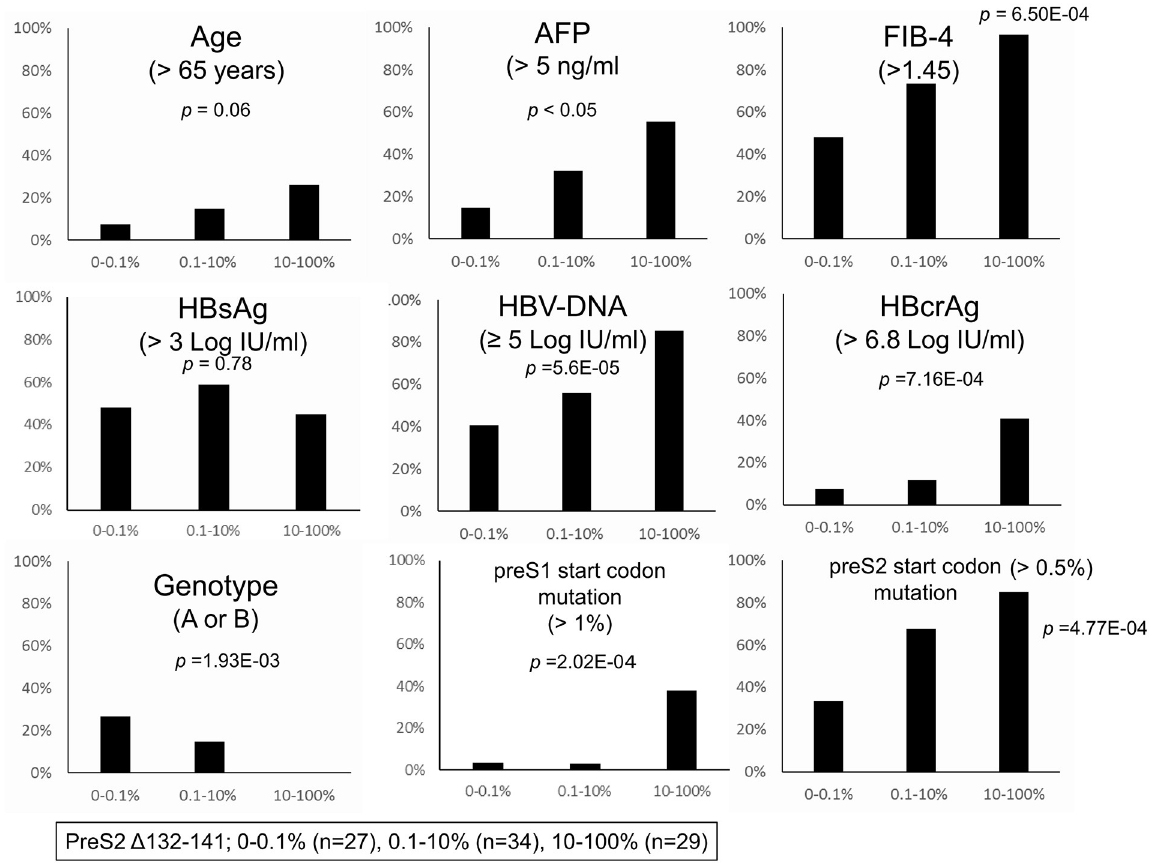
Fig 4. The correlations between the frequency of preS codon 132–141 deletions and host factors and viral markers. The correlations between the frequency of preS codon 132-141deletions deletions and host factors (age, AFP, and FIB-4) and viral markers (HBV DNA, HBcrAg, genotype and preS1/S2 start codon mutations) are